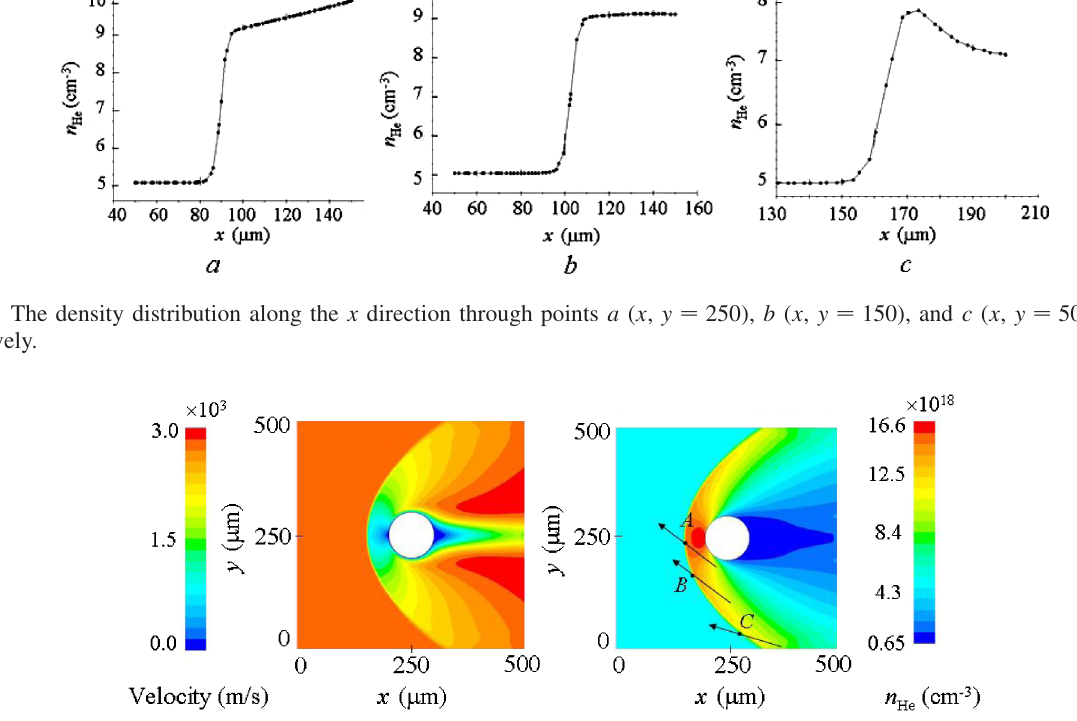
FIG. 5. The contours of the velocity (left frame) and the density (right frame) 200 ns after inserting the cylinders into the Mach 3 flow. Arrows indicate laser propagation direction.